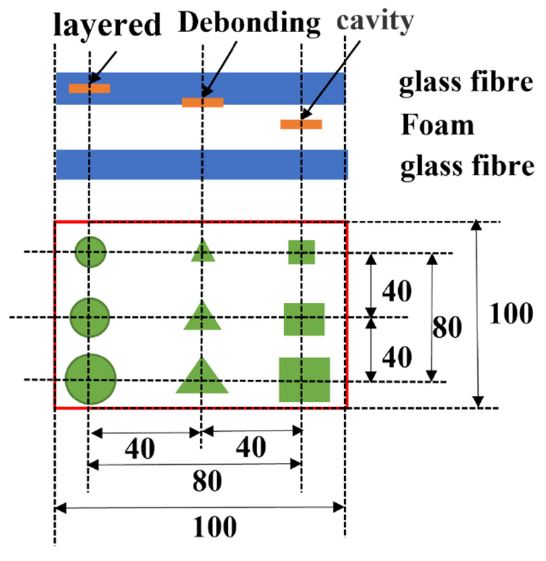
Figure 6. Three types of defect distributions.